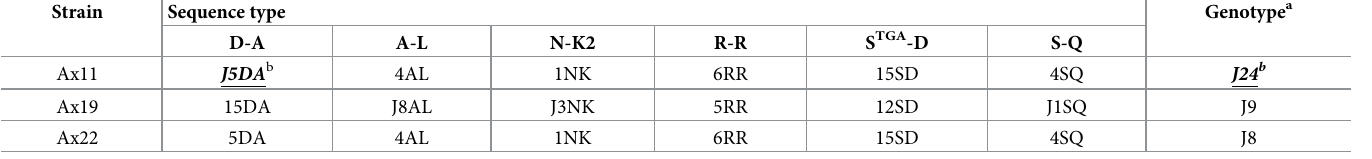
Table 1. Genotypes of the three isolated clinical strains as determined using transfer RNA-linked short tandem repeats.